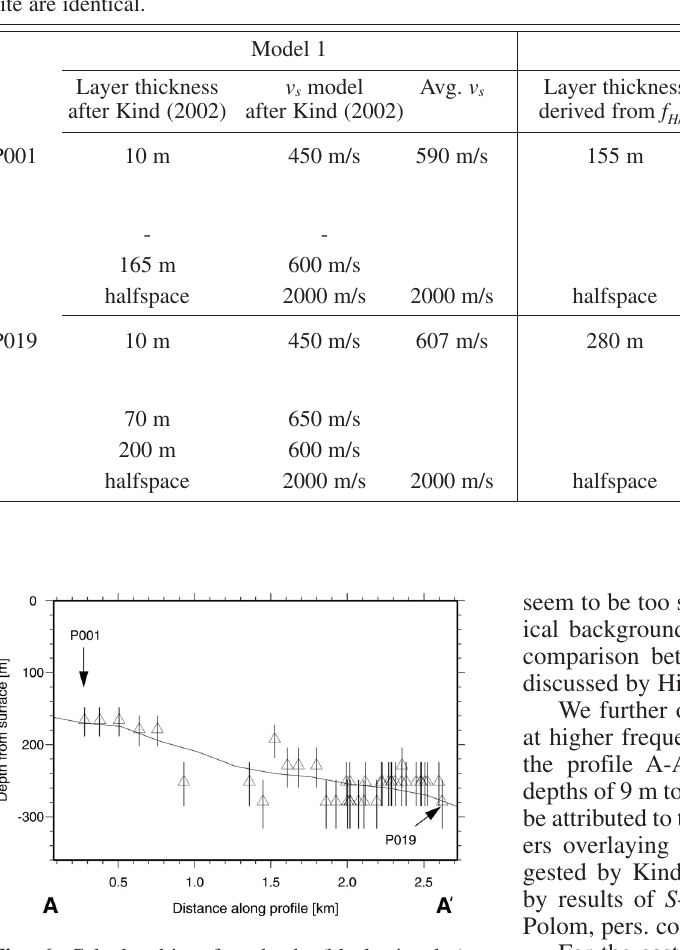
Fig. 6. Calculated interface depths (black triangles) h from fundamental peak frequencies f 0 (10% uncer- tainty: black error bars) after Hinzen et al. (2003) based on the «shear wave resonance» and a power law velocity depth distribution leading to an empiri- Vb = . The solid line rep- cal relation of the form: h af / H resents the depth of the dominant seismic contrast af- ter Kind (2002) for profile A-A ′